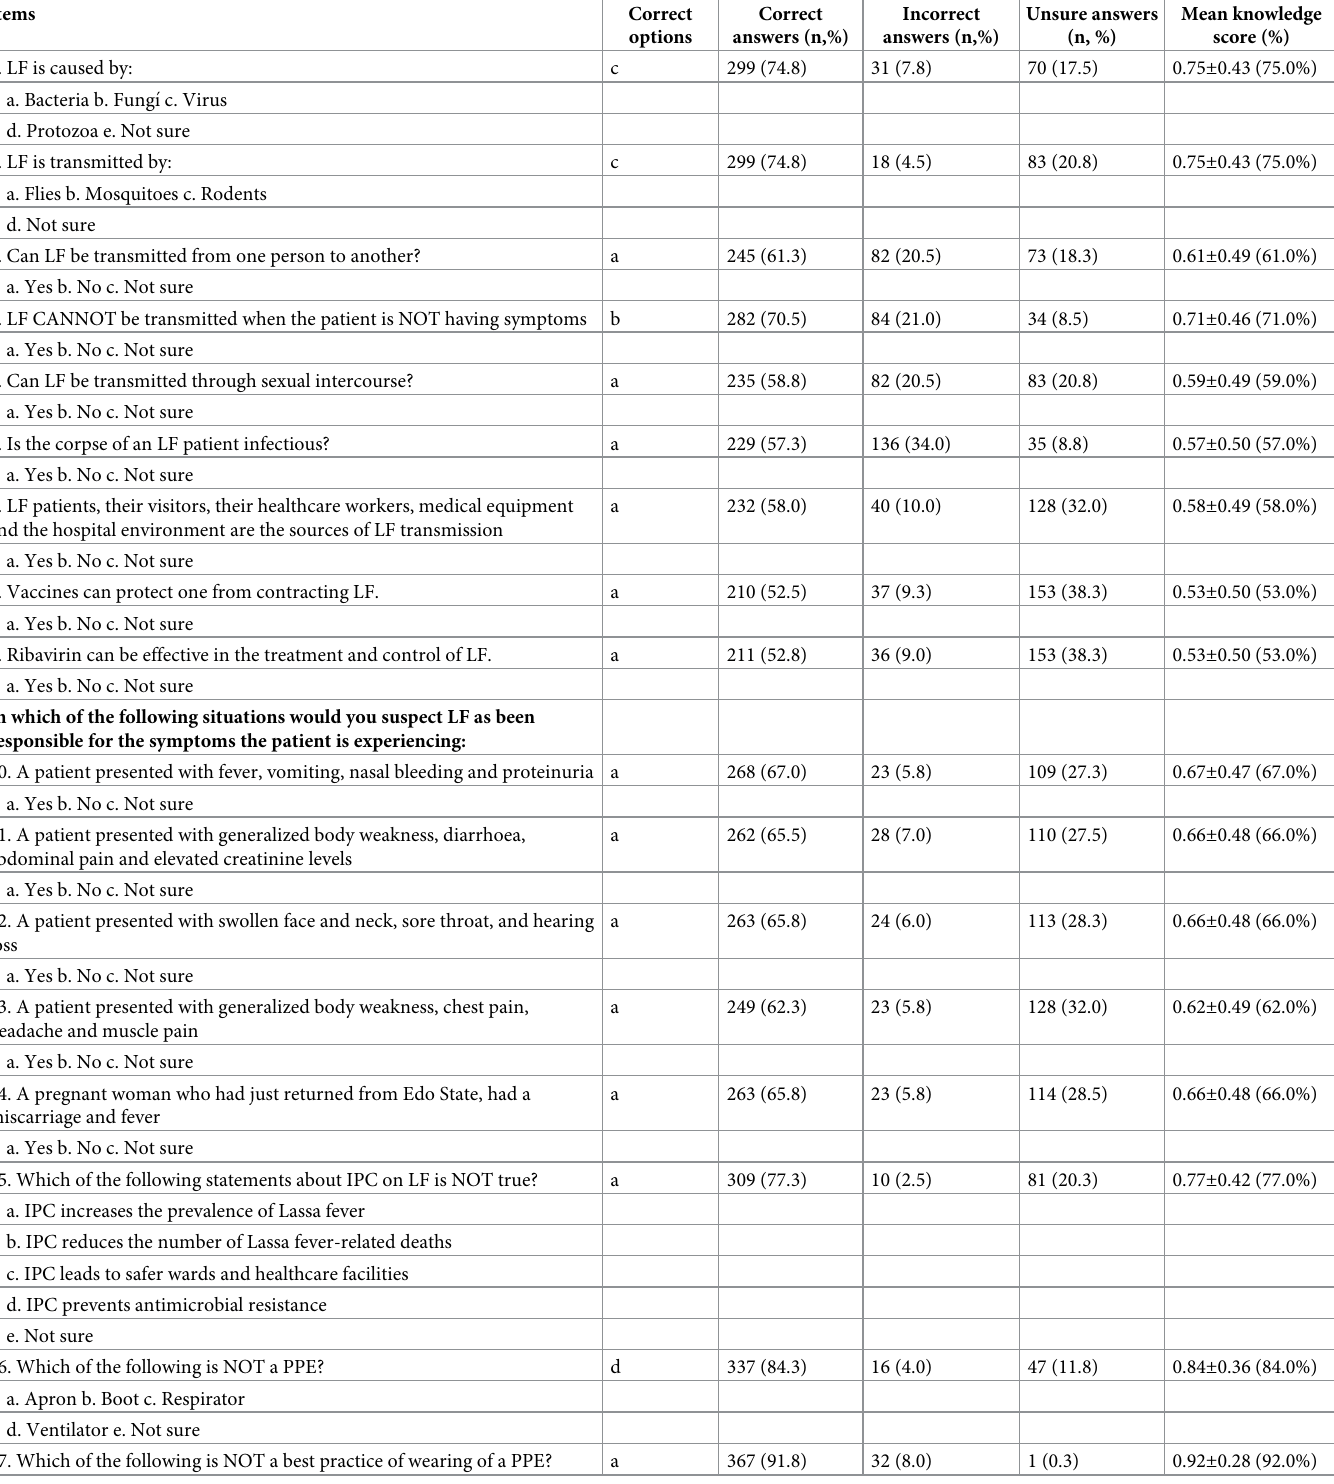
Table 4. Knowledge of Lassa fever symptoms, transmission and its prevention and control measures among healthcare workers during an outbreak in Katsina (N = 400).